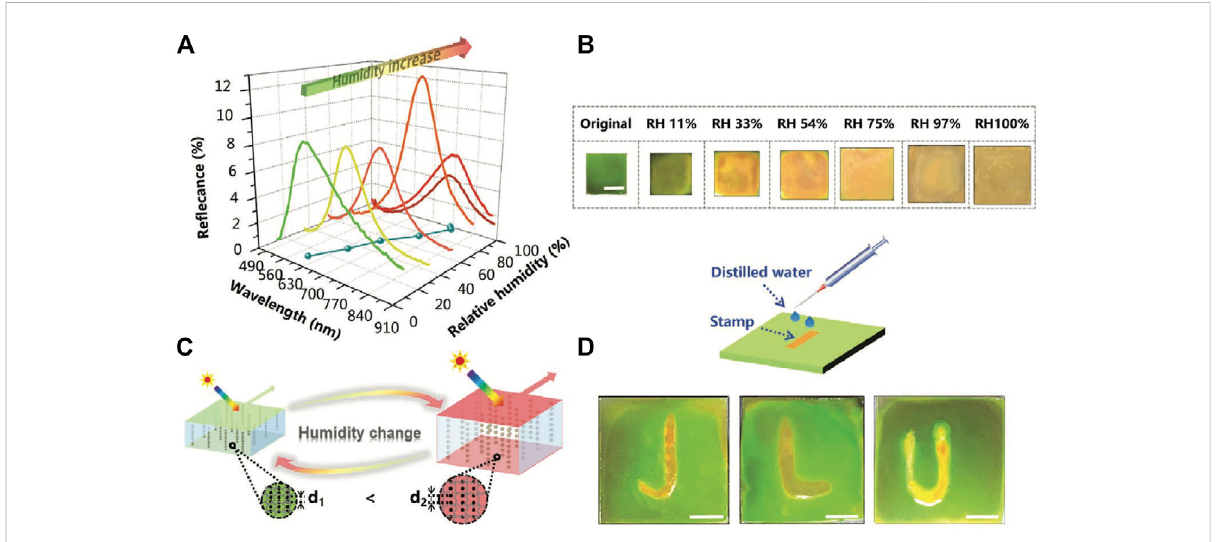
FIGURE 8 Structured color hydrogel fi lm with response to humidity. (A) Re fl ection spectra. (B) Photographs of the hydrogel fi lm under different relative humidity. (C) Schematicdiagramofthediscolorationmechanismofthehydrogel fi lm. (D) Schematicdiagramofwritingletterswithdistilledwateron the photonic display tablets and reasonably accurate digital photos. Scale bar = 0.5 cm. [Reproduced with permission from (Xue et al., 2021a) Copyright 2021 American Chemical